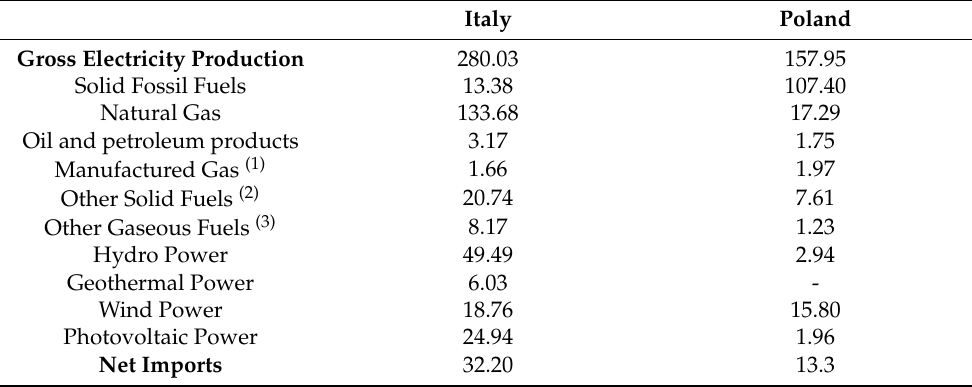
Table 9. Electricity mix in Italy and Poland in 2020. Values are reported in